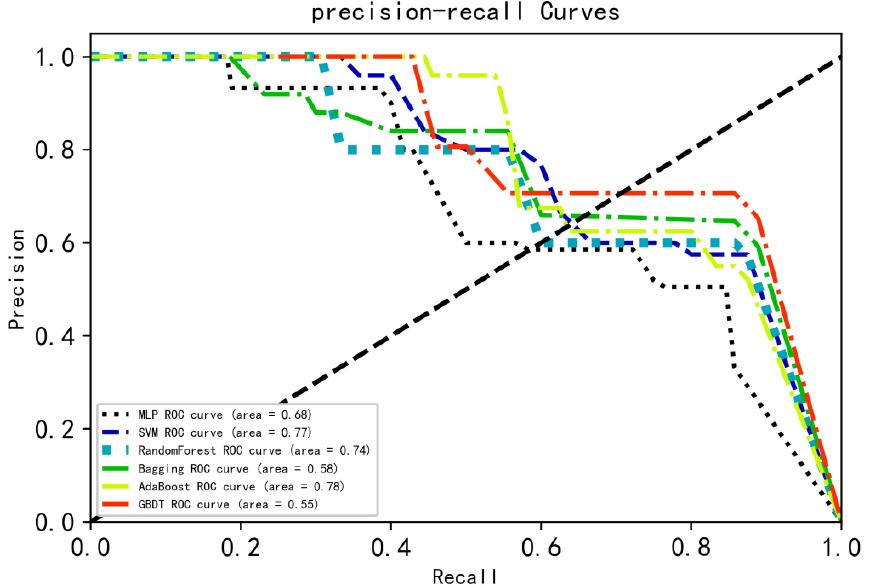
Figure 13. Precision-recall curves for six machine learning algorithms using REF-Top20 by k-fold cross-validation.